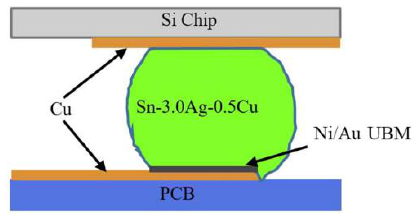
Figure 3. Cross section of solder bump.